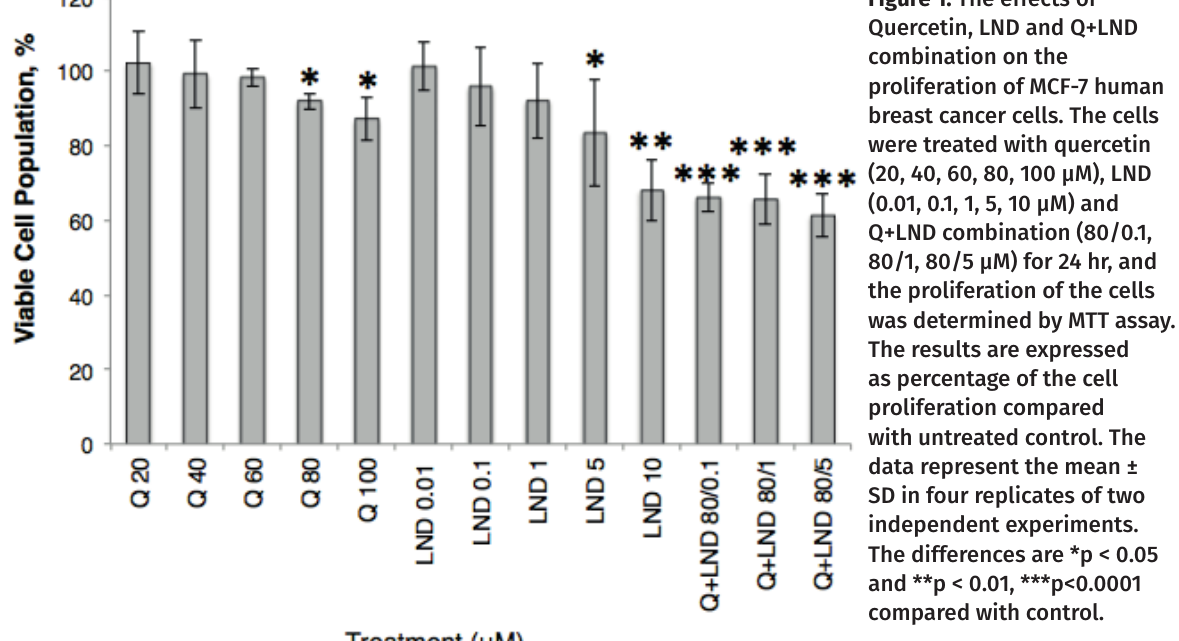
Figure 1. The effects of Quercetin, LND and Q+LND combination on the proliferation of MCF-7 human breast cancer cells. The cells were treated with quercetin (20, 40, 60, 80, 100 μM), LND (0.01, 0.1, 1, 5, 10 μM) and Q+LND combination (80/0.1, 80/1, 80/5 μM) for 24 hr, and the proliferation of the cells was determined by MTT assay. The results are expressed as percentage of the cell proliferation compared with untreated control. The data represent the mean ± SD in four replicates of two independent experiments. The differences are *p < 0.05 and **p < 0.01, ***p<0.0001 compared with